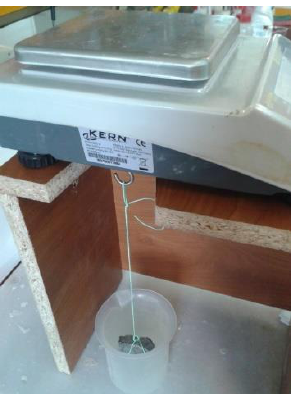
Figure 3. Apparatus for the immersed apparent mass determination.